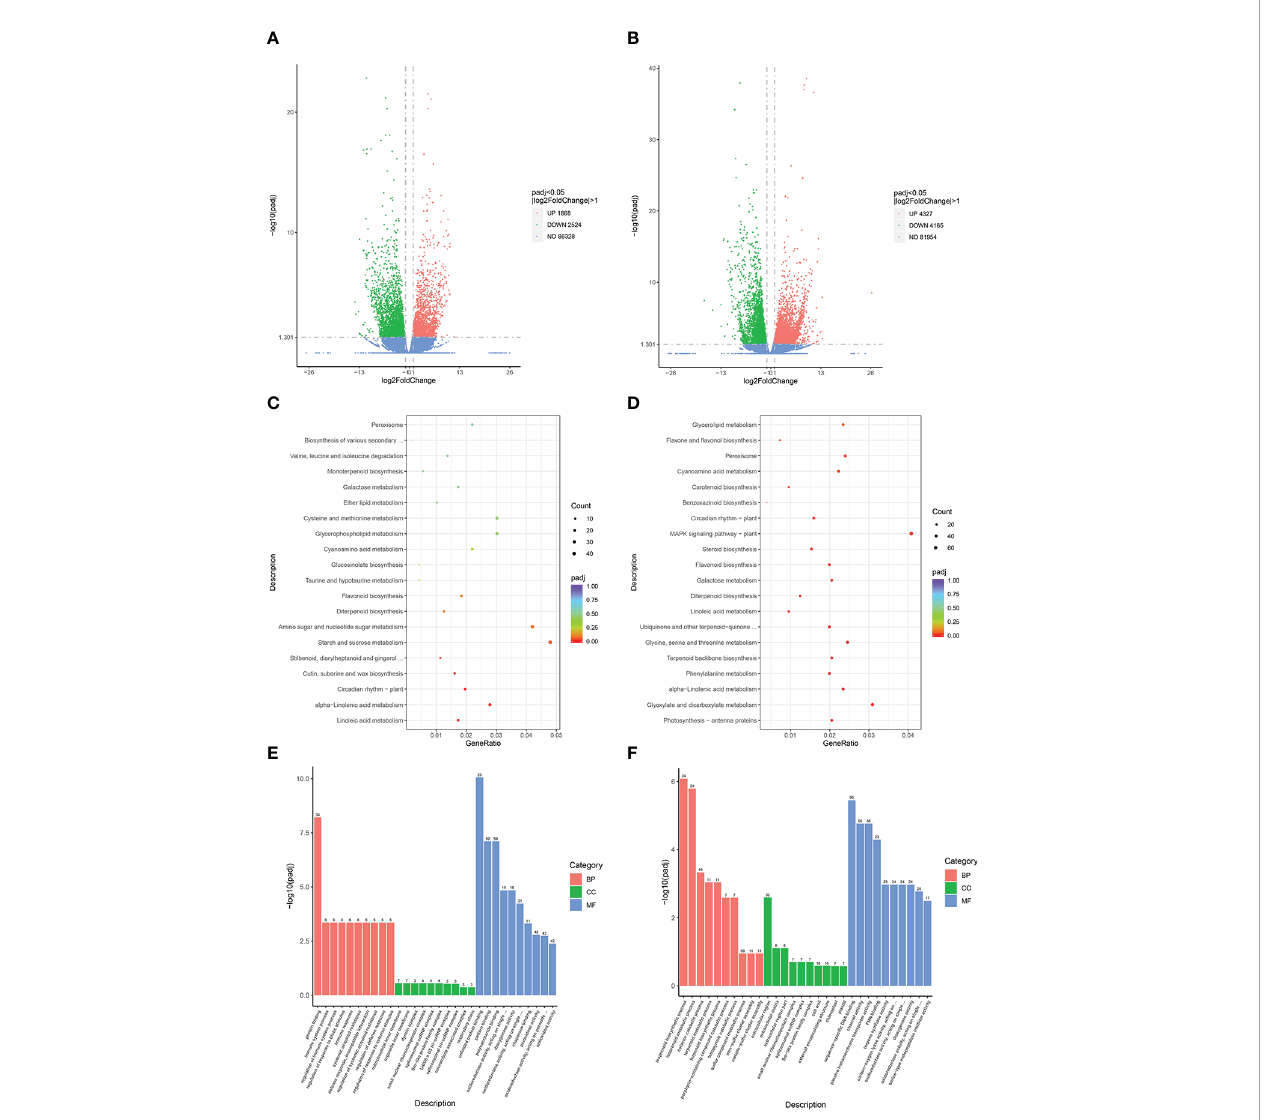
FIGURE 1 DEG analyses of wheat cv. Jimai229 and HHG46 with vs without powdery mildew inoculation. Volcano plots indicating DEGs in (A) JM229-pm/JM229-0 and (B) HHG46-pm/HHG46-0. Kyoto Encyclopedia of Genes and Genomes enrichment analysis of the DEGs from (C) JM229-pm/JM229-0 and (D) HHG46-pm/HHG46-0. Gene Ontology enrichment analysis of the DEGs from (E) JM229-pm/JM229-0 and (F) HHG46-pm/HHG46-0. BP, biological process; CC, cellular component; DEG, differentially expressed gene; MF, molecular